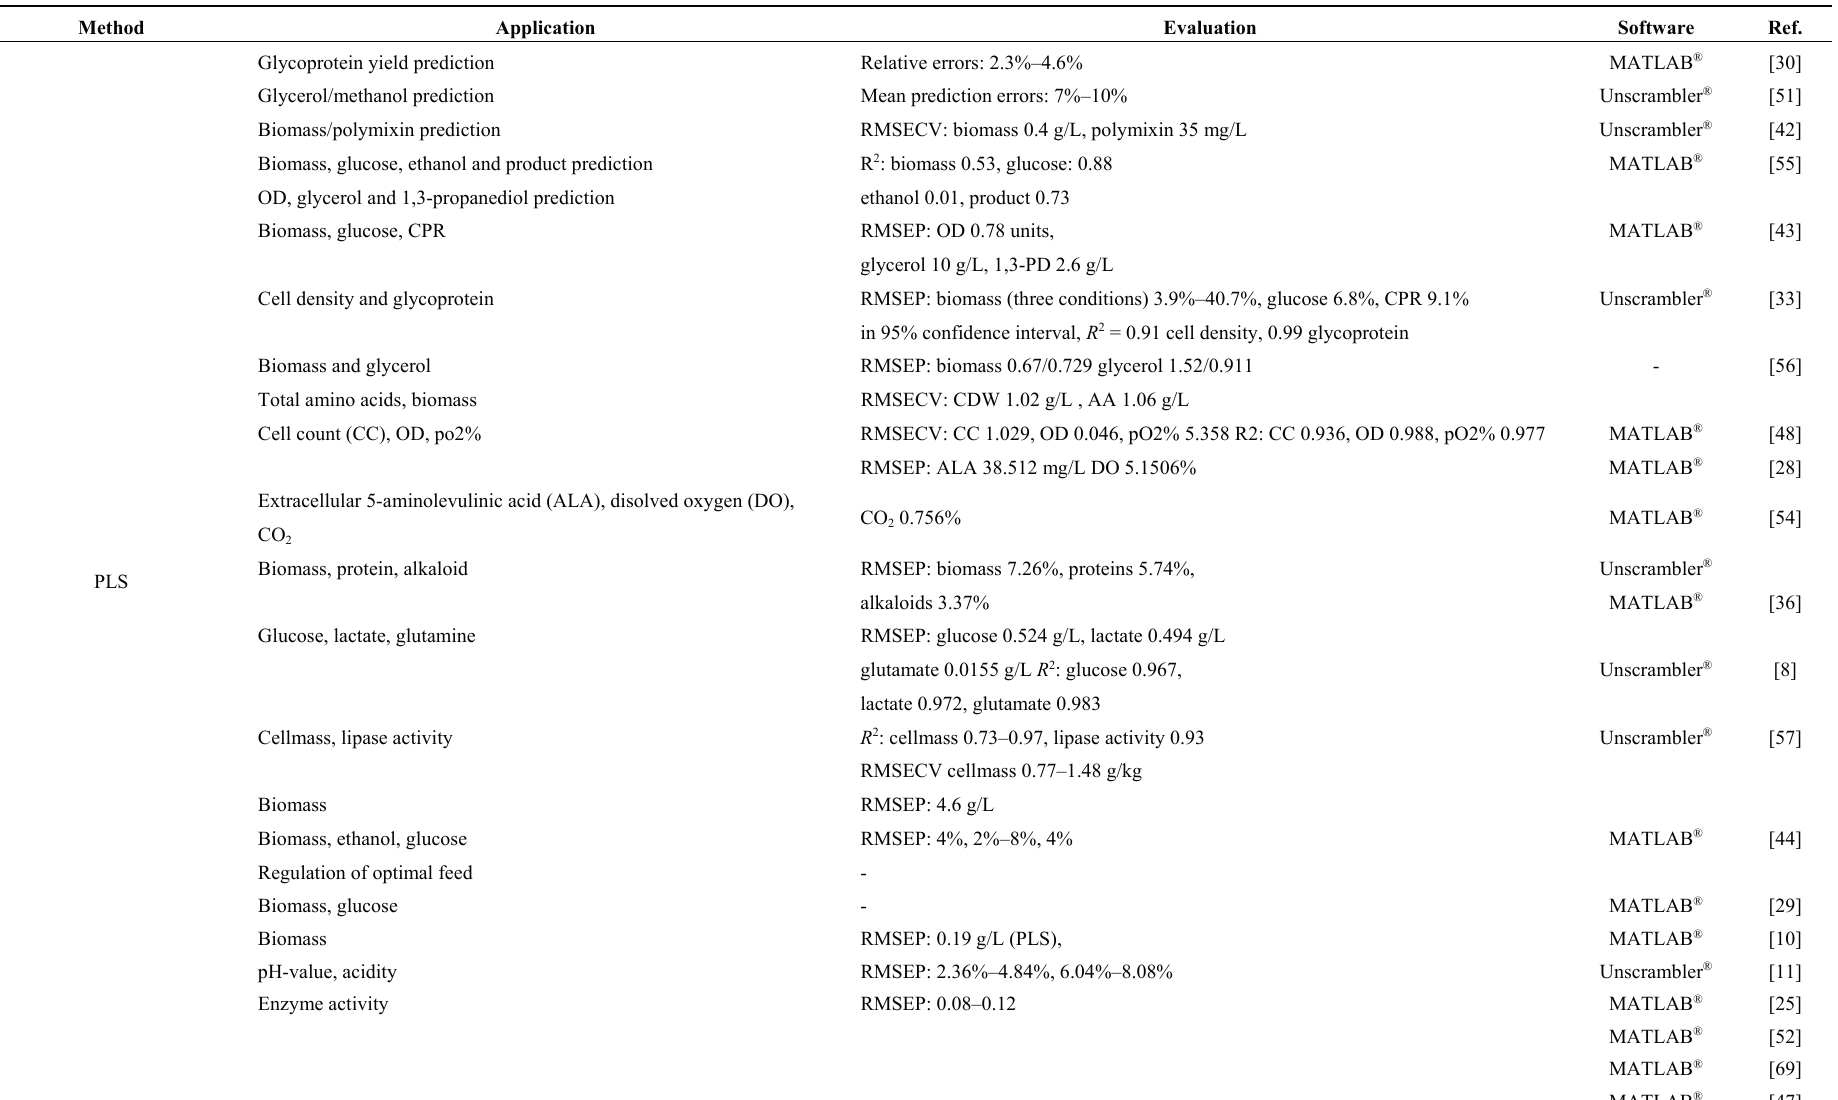
Table 5. Process models and